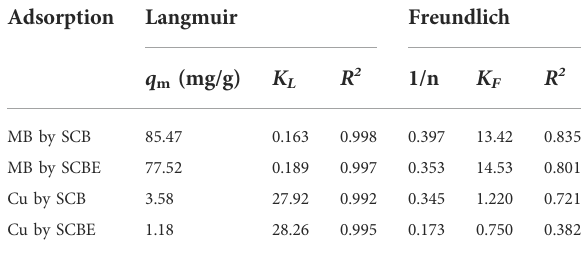
TABLE 2 Isothermal parameters for MB dye and Cu 2+ adsorption by SCB or